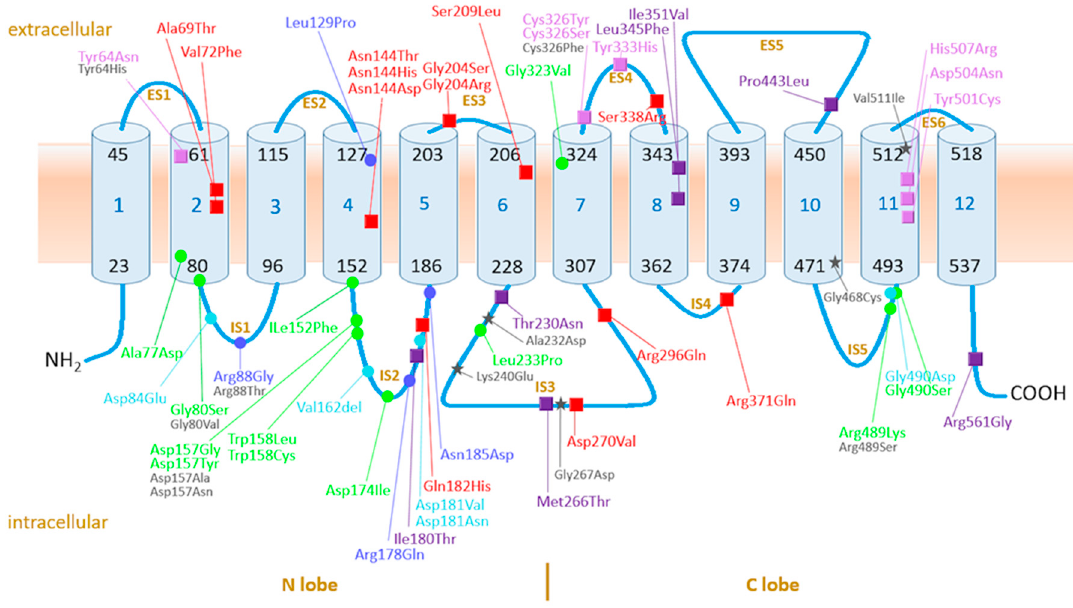
Figure 3. The two-dimensional (2D) structure of ferroportin protein adapted from Liu and Wallace [6,56], revealing 12 transmembrane helices and six extracellular and five intracellular segments. All the variants described in this review are shown as hepcidin-resistant (pink), hepcidin-sensitive or neutral (purple) and hepcidin conflicting/uncertain/unknown (red) GOF variants (squares). and hepcidin resistant (light blue), hepcidin sensitive (dark blue), and hepcidin conflicting-uncertain-unknown (green) LOF variants (dots), or non-classified variants (grey asterix).